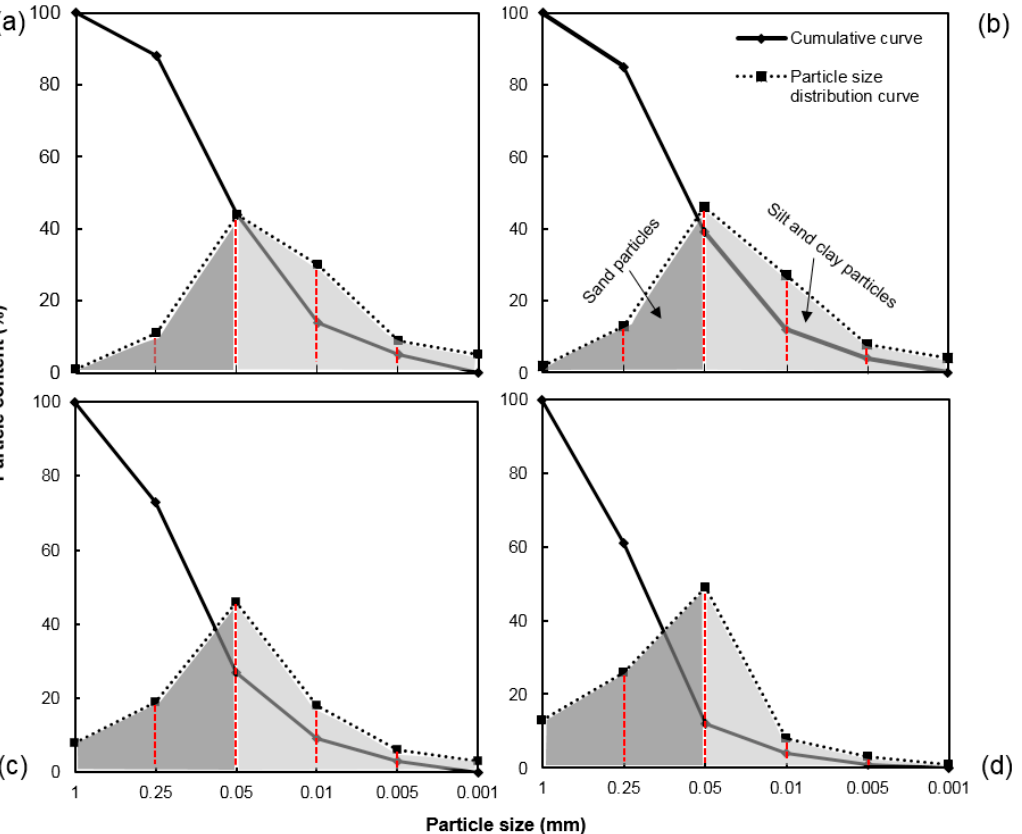
Figure 2. Effects of different dosages of DewEco (DE) on sandy soil particle composition. ( a ) con- trol: without DewEco. ( b ) 0.4 g DewEco kg 1 sandy soil (DE 0.4). ( c ) 0.6 g DewEco·kg − 1 sandy soil (DE 0.6). ( d ) 0.8 g DewEco·kg − 1 sandy soil (DE 0.8). Note. The size of the shaded area represents the proportions of soil particles, where dark gray represents sand particles and light gray represents silt and clay particles. The cumulative curve indicates the sum of soil particles below or equal to a cer- tain particle size.